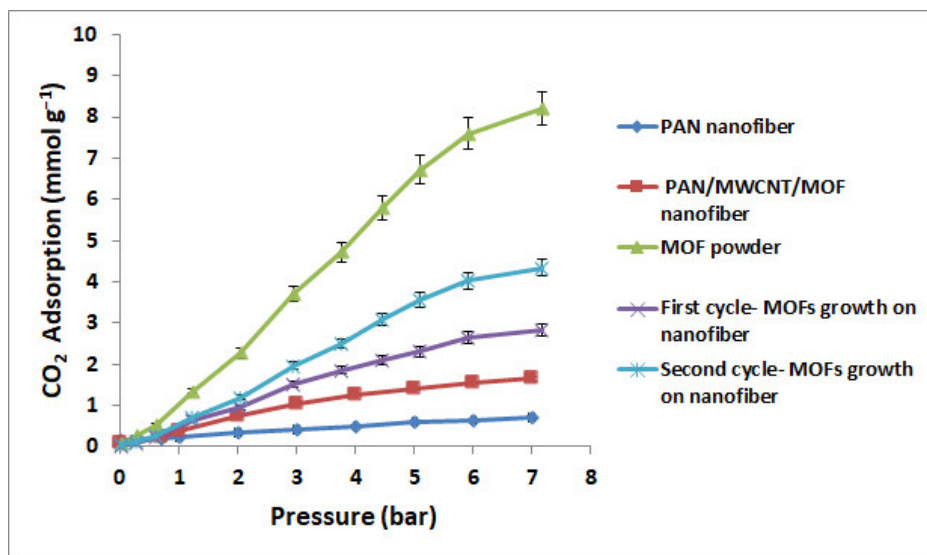
Figure 14. CO 2 adsorption of PAN nanofiber, PAN/MWCNT/MOF nanofiber, MOF powder, first cycle—MOFs growth on nanofiber, second cycle—MOFs growth on nanofiber, and at 25 ◦ C.